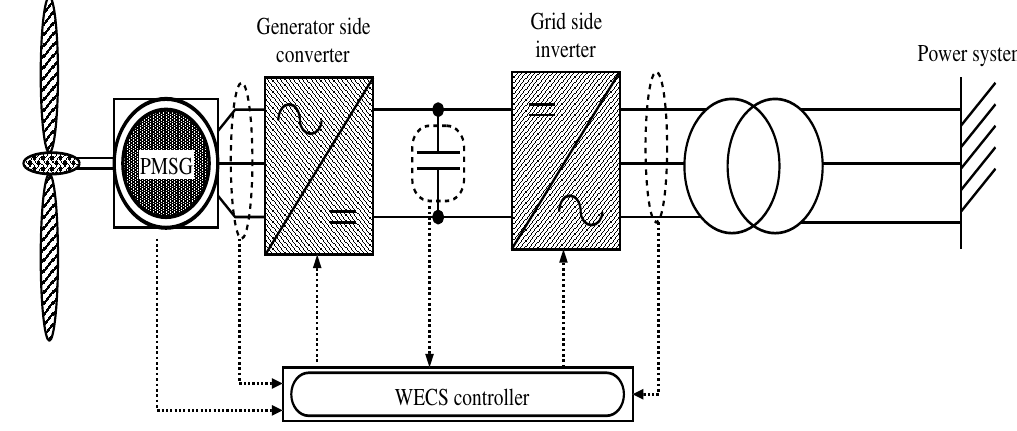
Figure 2. PMSG based wind energy conversion